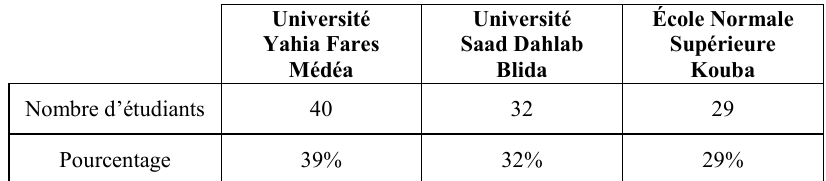
Table 1. Répartition des étudiants